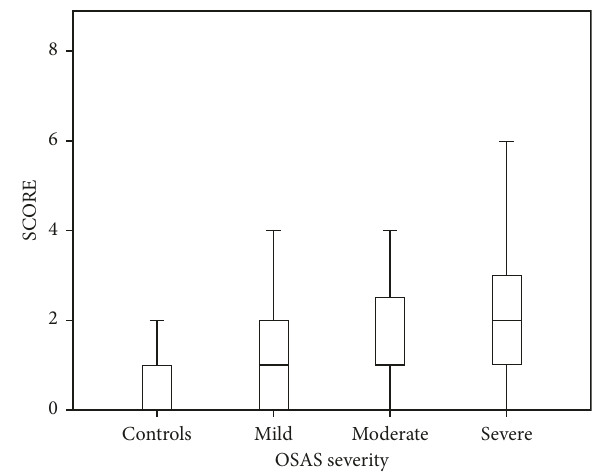
Figure 1: Comparison of Systematic Coronary Risk Evaluation (SCORE) score between controls and obstructive sleep apnea syndrome (OSAS)